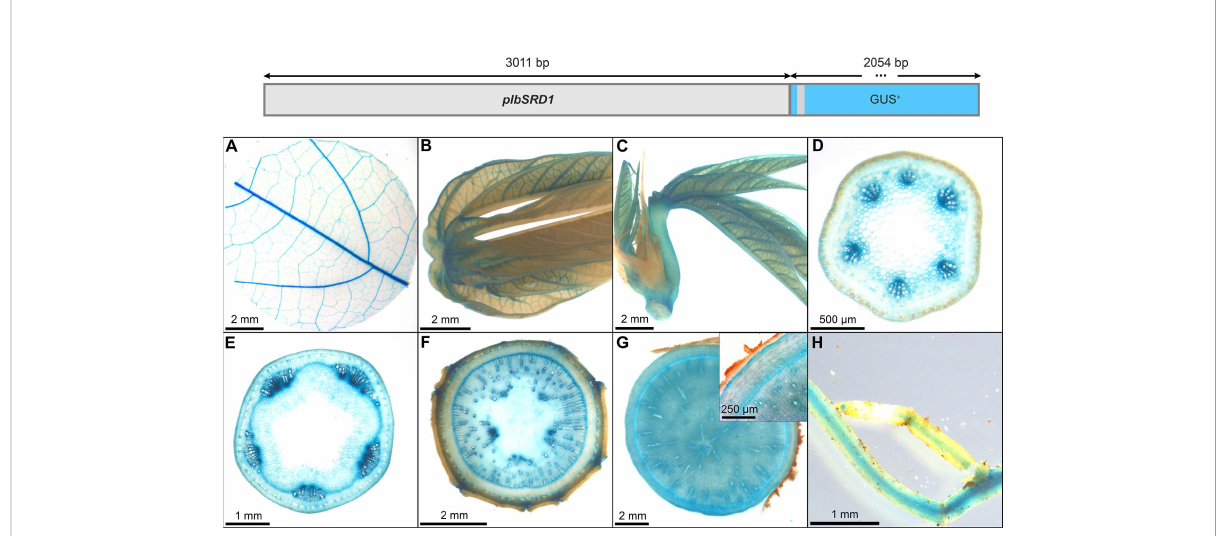
FIGURE 13 Representative GUS staining pattern of at least four pIbSRD1 promoter-reporter lines. (A) Source leaf, (B) Sink leaf, (C) Emerging leaves, (D) Petiole cross-section, (E) Upper stem cross-section, (F) Lower stem cross-section, (G) Storage root cross-section (Inlay = Close-up), (H) Fibrous